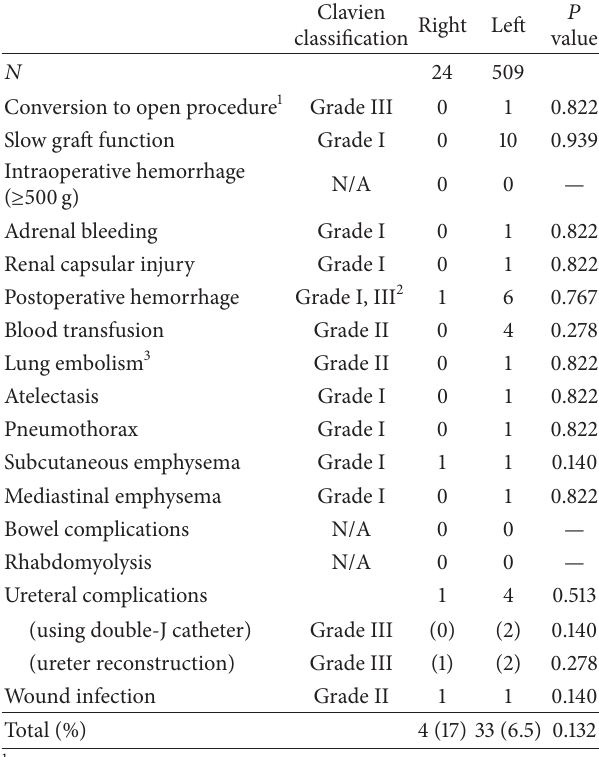
Table 4: Complications of right RPLDN and ureteral complications in